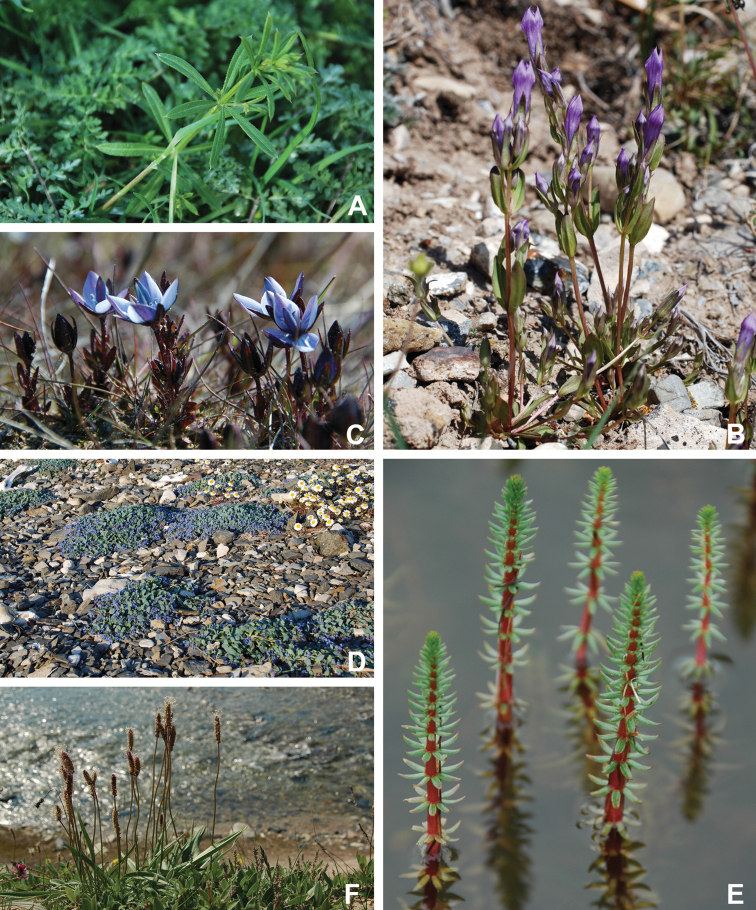
AGalium
aparine habit, Saarela and Teeter 5295BGentianella
propinqua
subsp.
propinqua habit, Gillespie et al. 9619CLomatogonium
rotatum
subsp.
rotatum habit, Gillespie et al. 8109DMertensia
maritima
subsp.
tenella habitat, Saarela & Bull 1469EHippuris
lanceolata habit, Johansen Bay, NU, 18 July 2008 FPlantago
canescens habit, Gillespie et al. 8103. Photos A, B, D by J.M. Saarela and C, E, F by R.D. Bull.